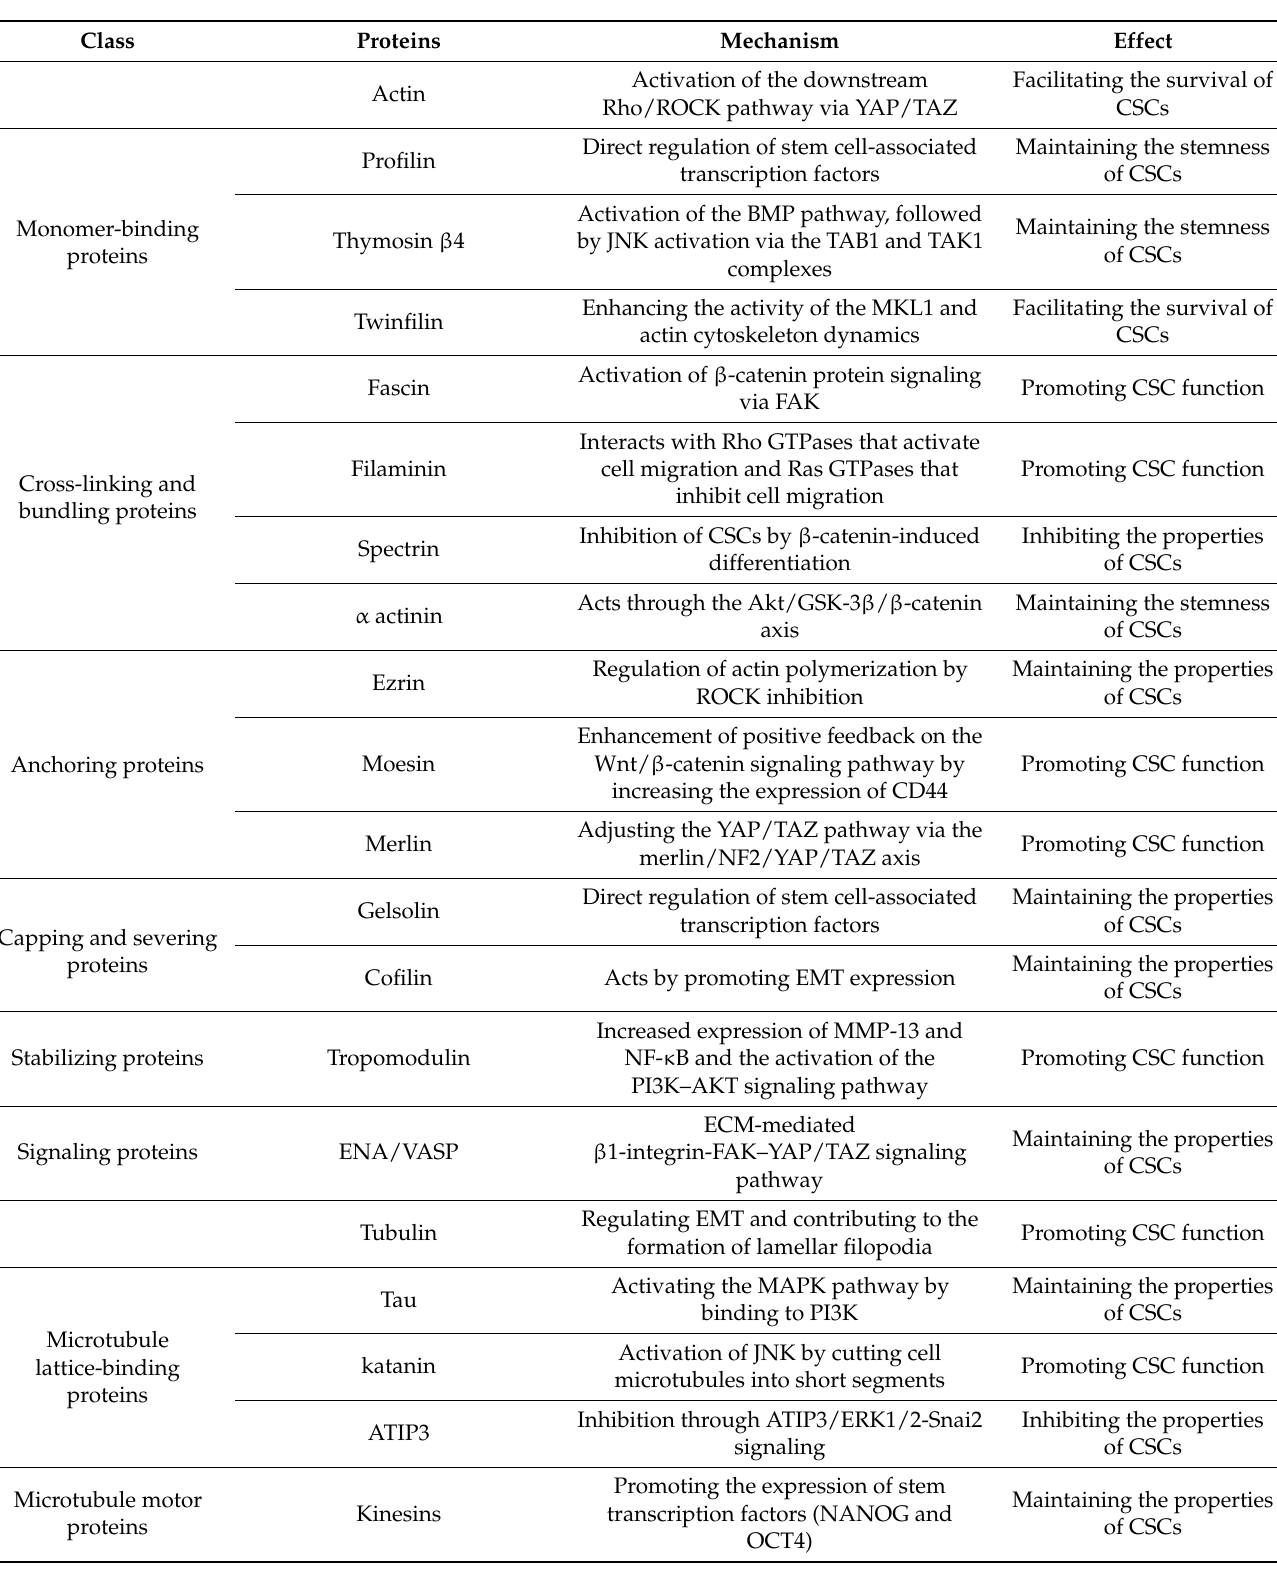
Table 1. Mechanism of cytoskeleton and cytoskeleton-related proteins on